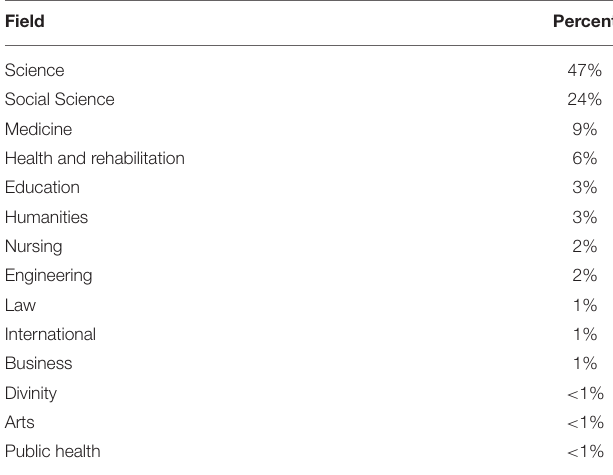
TABLE 3 | Field of highest degree in individuals reporting high neuroscience